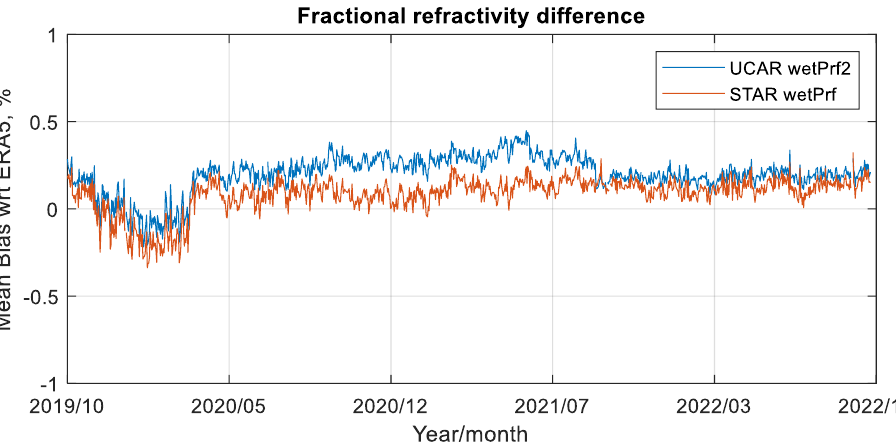
Figure 13. The time series of the fractional difference between COSMIC-2 refractivity and ERA-5- simulated refractivity at 700 mb for STAR WetPrf (in red) and UCAR WetPrf2 (in blue).